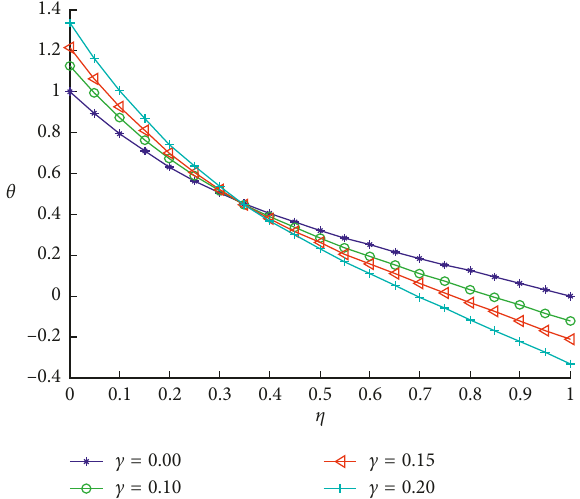
Figure 9: Effect of the jump parameter on the temperature profile when A Nb 0 . 2 , c 0 . 1 , M 0 . 5 , Le (cid:31) (cid:31) (cid:31) (cid:31) (cid:31) 1 . 0 , and C